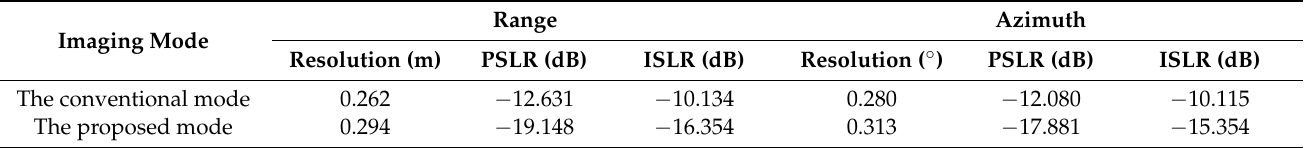
Figure 13. Experiments via a ground − based SAR system. ( a ) The ground − based SAR system for experiments. ( b ) Experi- mental site with three corner reflectors. ( c ) Imaging result of the conventional mode. ( d ) Imaging result of the proposed mode. ( e ) Contour plots of reflector B in the conventional mode. ( f ) Contour plots of reflector B in the proposed mode. Table 4. Measured focusing parameters of diagonal reflector B in Figure 13.